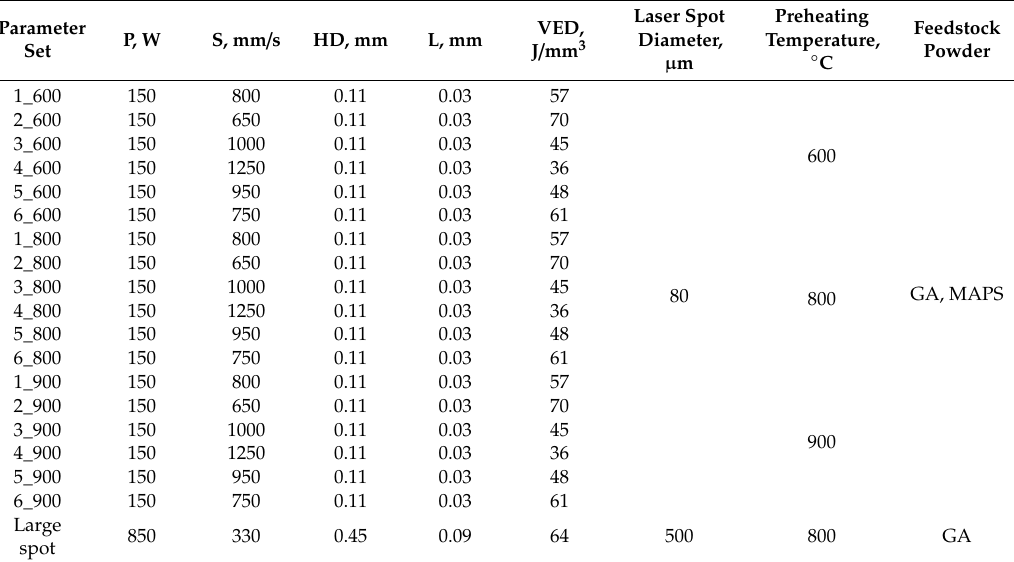
Table 1. The L-PBF process parameters used for to produce the